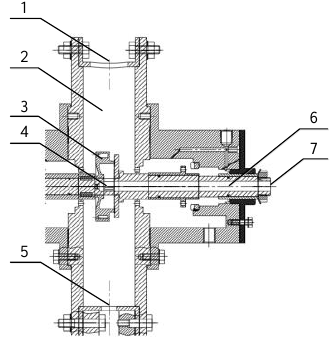
Figure 2. Experimental section of an impeller-type breather. Consists of: 1 inlet; 2 inner chamber; 3 impeller breather; 4 vent hole; 5 oil outlet; 6 hollow shaft; 7 air outlet.